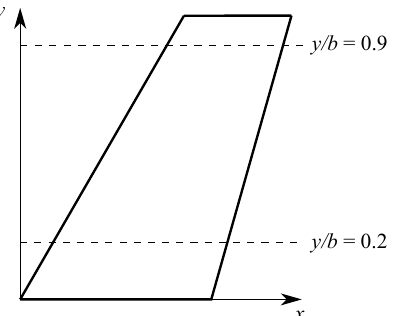
Figure 27. Convergence characteristics of flow equations.